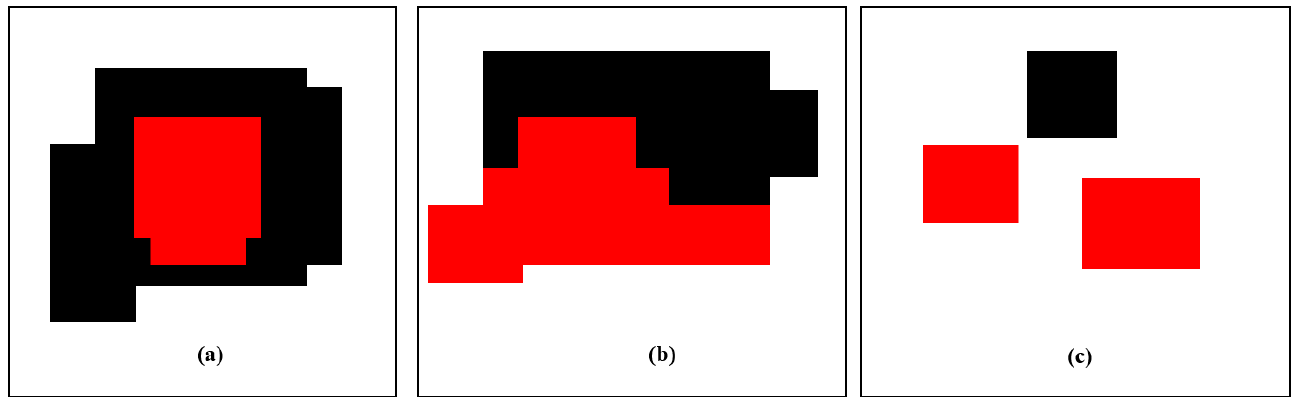
Figure 1. Urban expansion types: ( a ) Infilling expansion; ( b ) Edge expansion; and ( c ) Outlying expansion (black—existing development; red—urban growth).